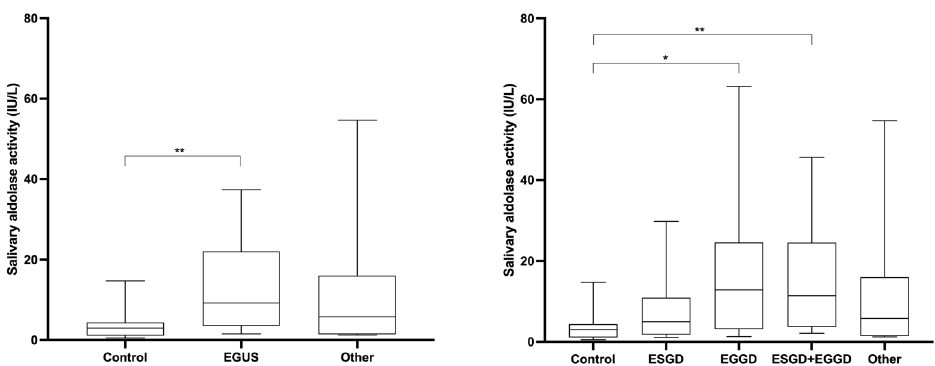
Figure 4. Salivary aldolase activity observed in healthy horses (Control), horses diagnosed with equine gastric ulcer syndrome (EGUS), and horses with similar symptomatology of EGUS but diagnosed with other gastrointestinal disorders (Other). The median values are represented by the lines, the 10–90 percentiles by the boxes, and the range by the whiskers. *: p < 0.05; **: p <